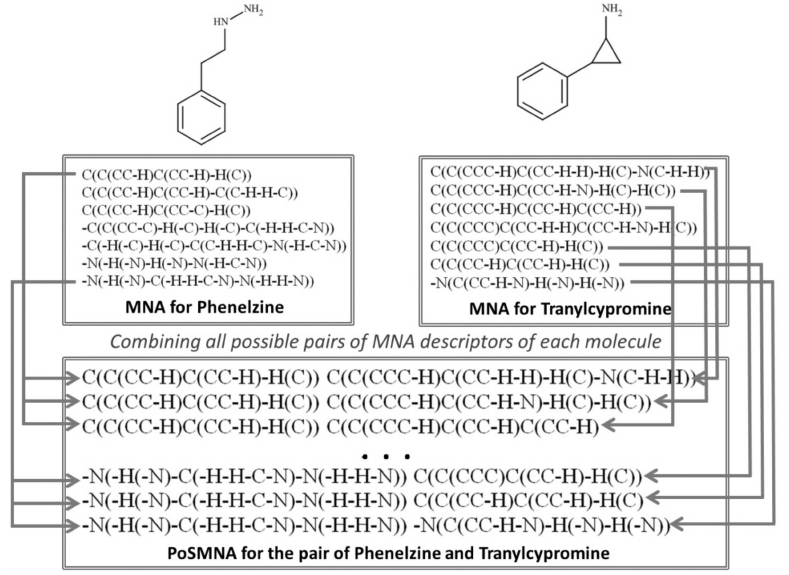
Figure 1. Representation of the Phenelzine and Tranylcypromine molecules by MNA and PoSMNA